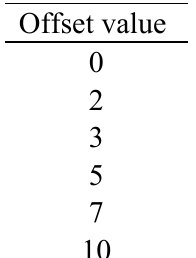
Table 2. Offsets used in constructing the simulated data for the radiometric normalization experiment.